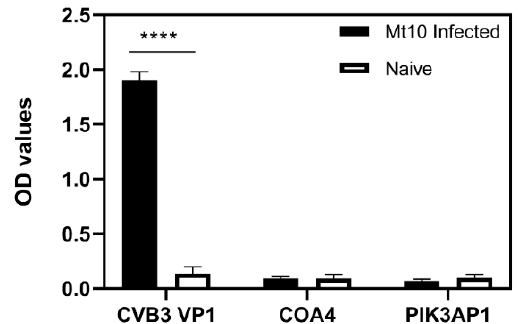
Figure 7. Appearance of autoantibodies to COA4 and PIK3AP1 requires infection with a virulent virus. A/J mice were infected with a modified live attenuated Mt10 CVB3 vaccine virus or saline, and after 21 days, serum samples were collected. Diluted serum samples (1:100) were added to plates coated with CVB3 VP1, COA4, or PIK3AP1. After incubation and addition of HRP-conjugated anti-mouse total Ig and substrate, reactions were stopped to measure the OD values at 450 nm. Mean ± SEM values in each group ( n = 3) are shown, with each sample representing the pool of sera from 3 to 4 mice. One-way ANOVA with Tukey’s test was used to determine significance between groups. **** p ≤ 0.0001.